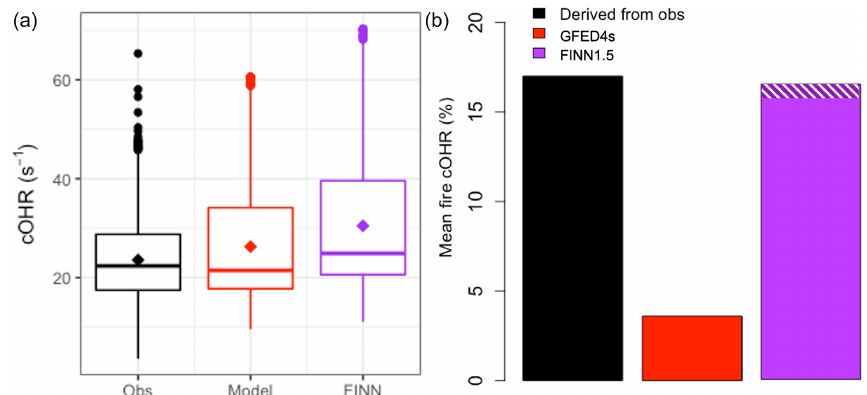
Figure 5. (a) Boxplots of cOHR during the October 2018 and September 2019 measurement periods at ATTO with observations in black and the model in red with medians shown as a horizontal line and means as diamonds. (b) The mean percentage contribution from fires during the same time period to cOHR with that derived from observations in black, the model with GFED4s in red, and a simulation using scaled-up FINN1.5 in purple. The white hatching on the FINN1.5 simulation indicates the increase in percentage contribution due to new EFs and chemistry.